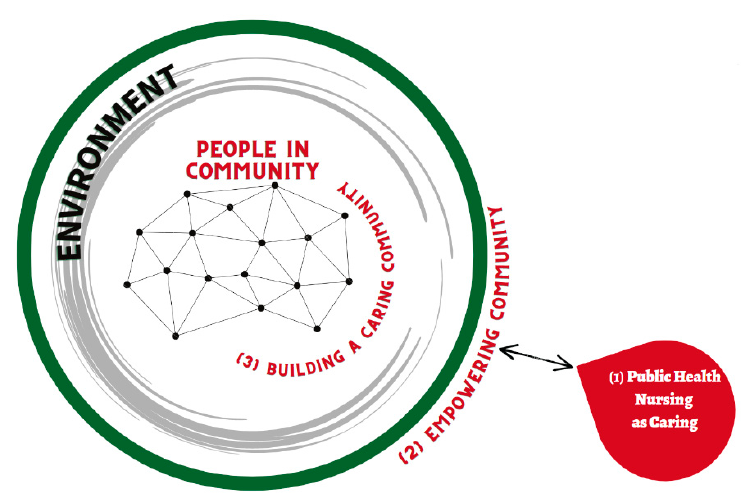
Figure 1. Three nursing processes in the theory of community caring for public health nurses.